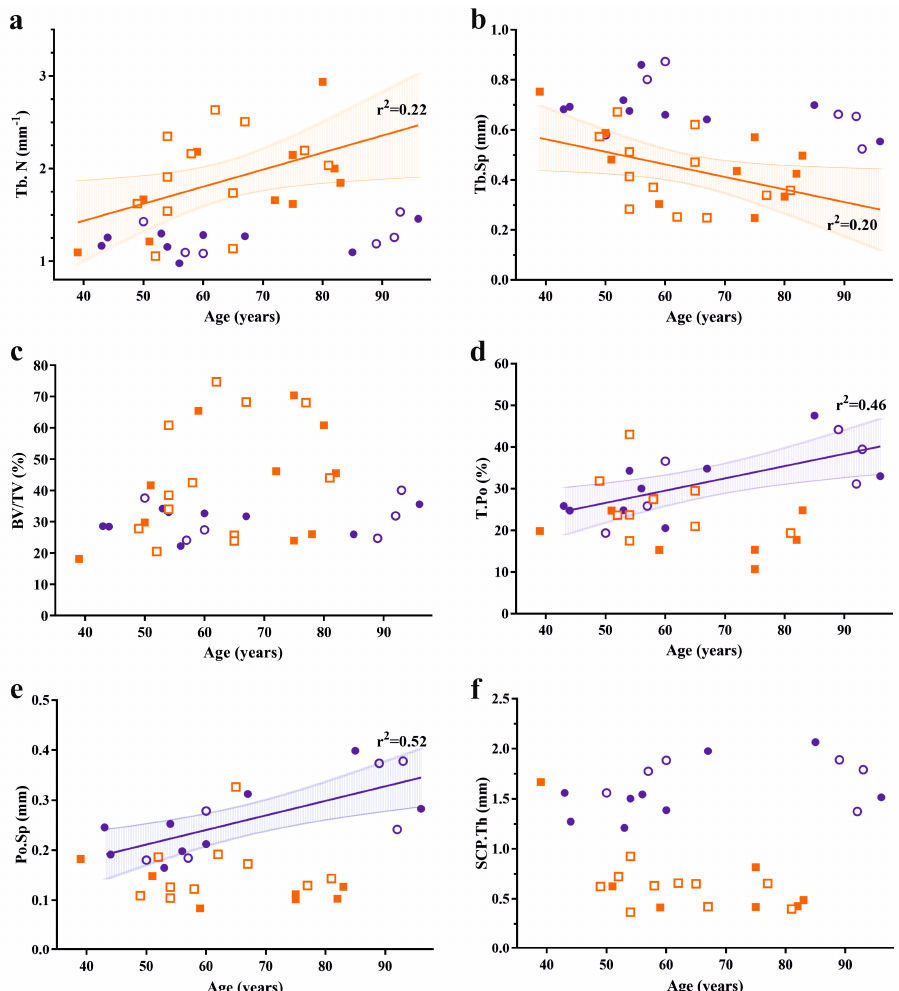
Figure 2. Age- and gender-related distribution of bone structural parameters in lumbar facet joints. Healthy facet joints are marked blue, FJOA specimens are marked orange. Males are represented by filled symbols, females by open symbols. Significant correlations with age are marked by regression lines with 95% confidence intervals and r 2 -values for healthy (blue) and osteoarthritic (orange) specimens. Distributions are shown for ( a ) trabecular number; ( b ) trabecular separation; ( c ) bone volume fraction ; ( d ) cortical plate porosity; ( e ) cortical pore space; and ( f ) cortical plate thickness.